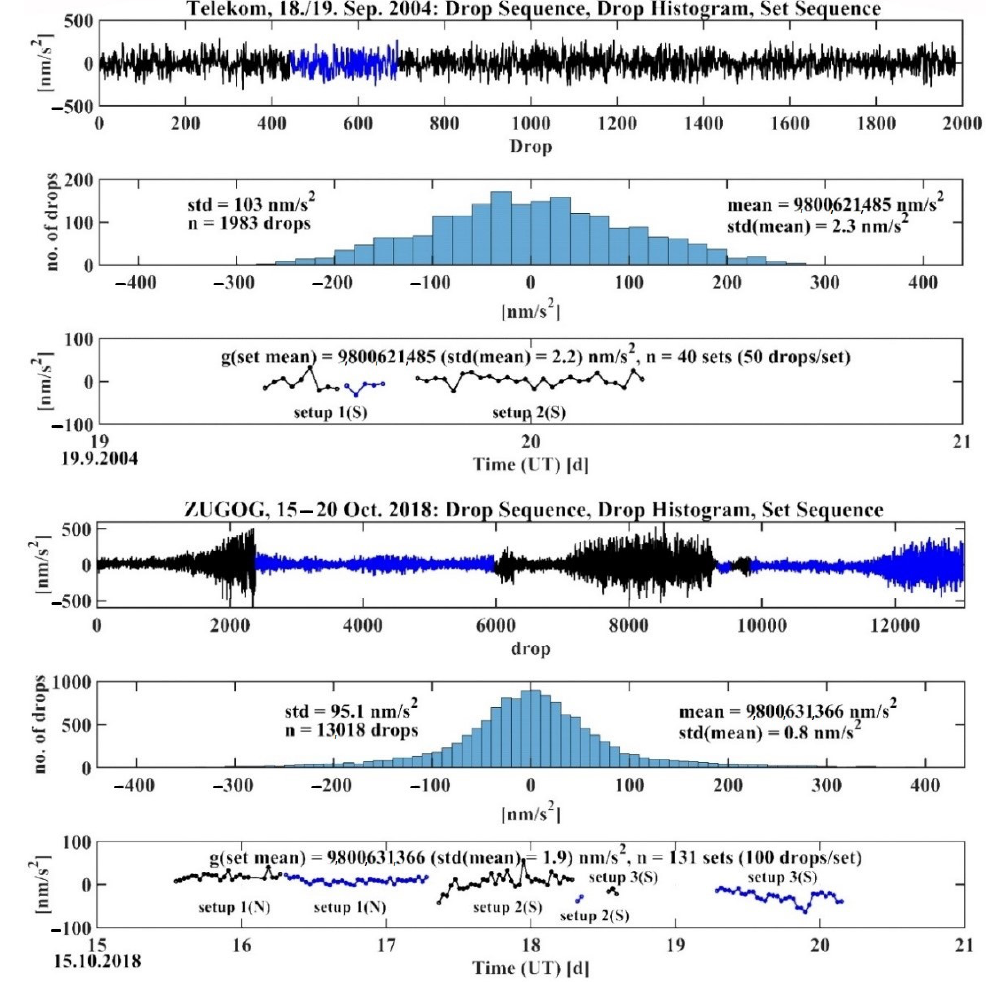
Figure A1. As an example for a station determination with the Hannover absolute gravimeter FG5 220, a statistical compilation at the Zugspitze sites Telekom (2004 with original FG5-220) and ZUGOG (2018 with FG5-220, X-version) is presented. Severe fluctuations in the room temperature within ZUGOG in 2018 are the reason for the inhomogeneous drop sequence and the observation of six runs which are partly very short because of instrumental